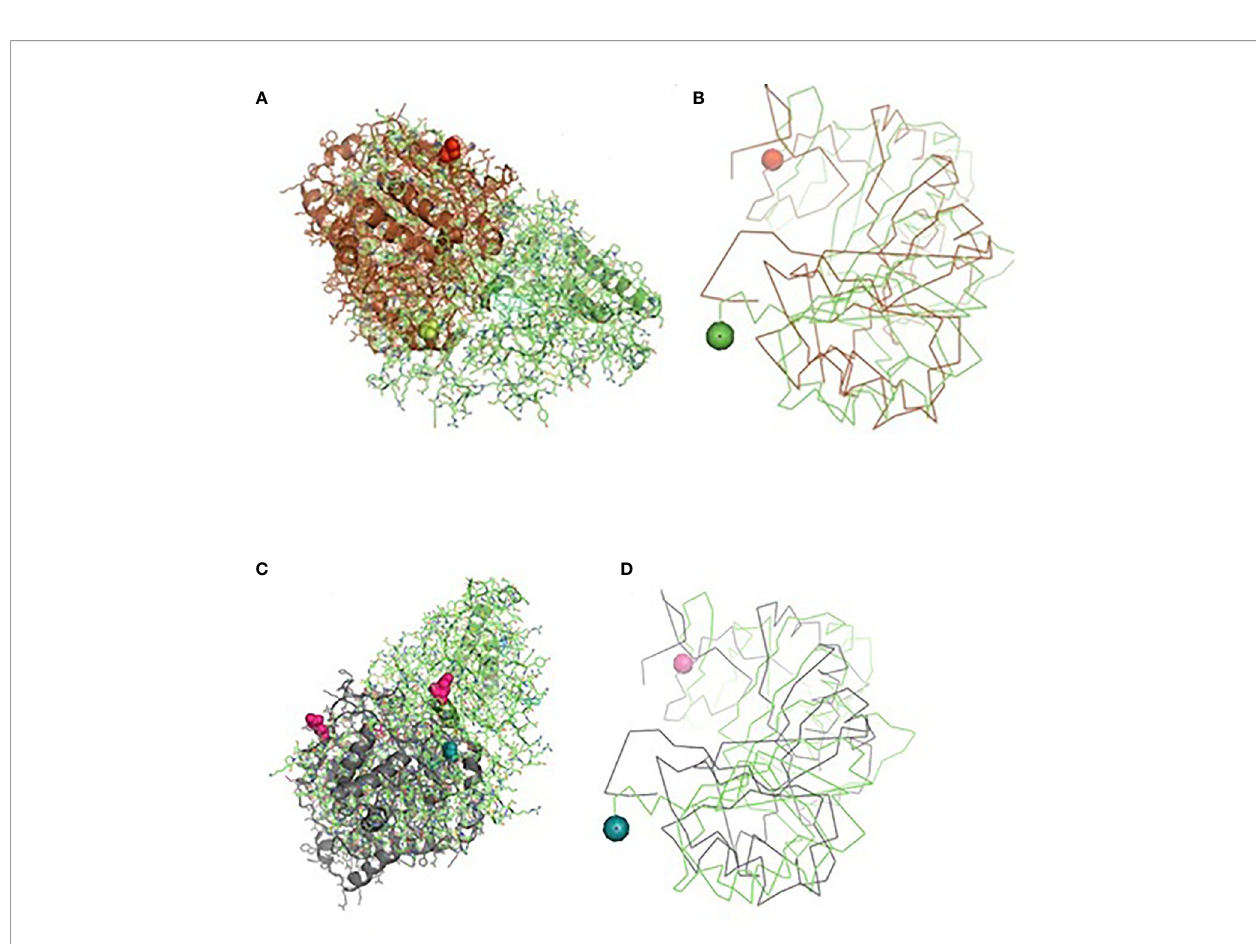
FIGURE 10 | Binding of ovine CD14 with alpha tubulin and beta tubulin of Haemonchus contortus. (A) Alignment of 3D structure of ovine CD14 molecule (green) with alpha tubulin (brown) of Haemonchus contortus. (B) Line drawing of binding site of CD14 molecule with alpha tubulin (brown) of Haemonchus contortus. (C) Alignment of 3D structure of ovine CD14 molecule (green) with beta tubulin (purple) of Haemonchus contortus. (D) Line drawing of binding site of CD14 molecule (green) with beta tubulin (purple) of Haemonchus contortus.